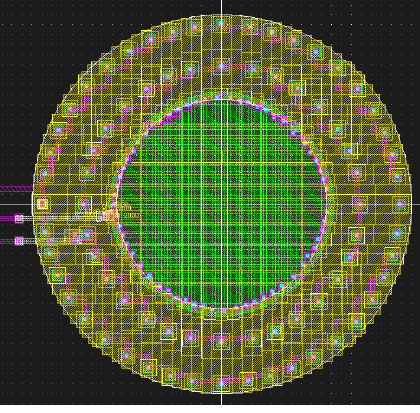
Figure 15. Layout of a circular BDJ PD, where low resistance access, low sidewall component and low crosstalk have been optimized at the expense of the Fill Factor